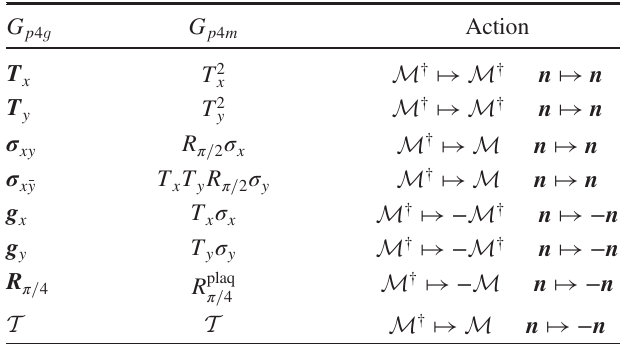
TABLE VI. The table shows the correspondence between the symmetries of the Shastry-Sutherland lattice ( p 4 g ) and square lattice ( p 4 m ). Bold symbols are for symmetries of the Shastry- Sutherland